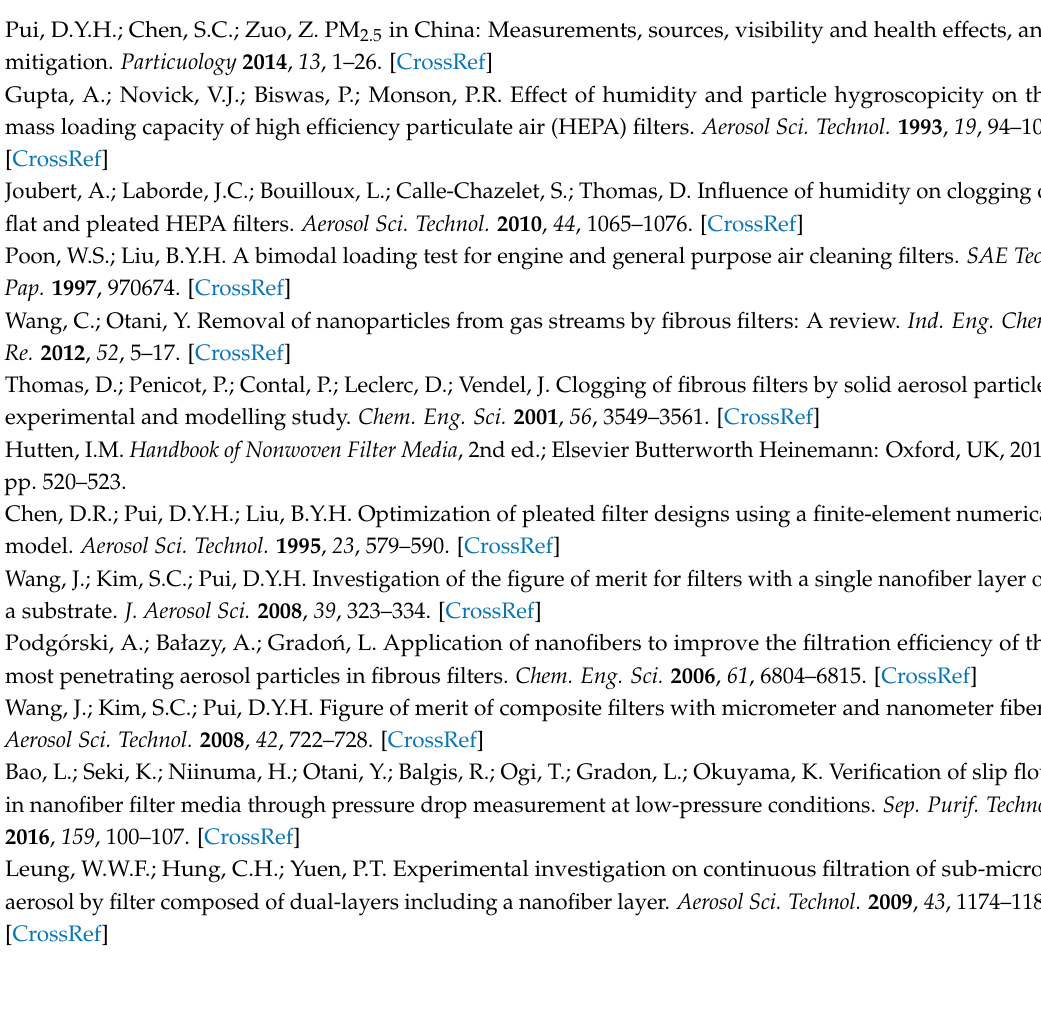
Table S1: Technical data sheet of Lyocell